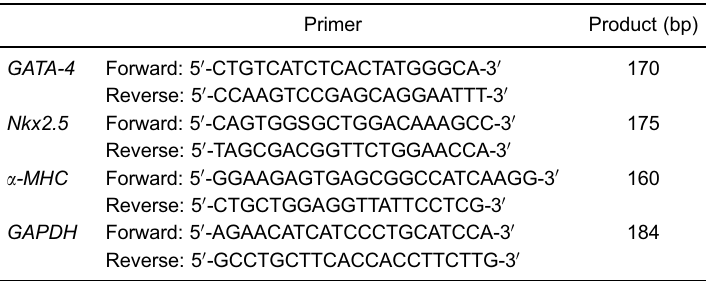
Table 1. GATA-4 , Nkx2.5 , a -MHC and GAPDH primers used for semi-quantitative RT-PCR in bone mesenchymal stem cells-cardiac